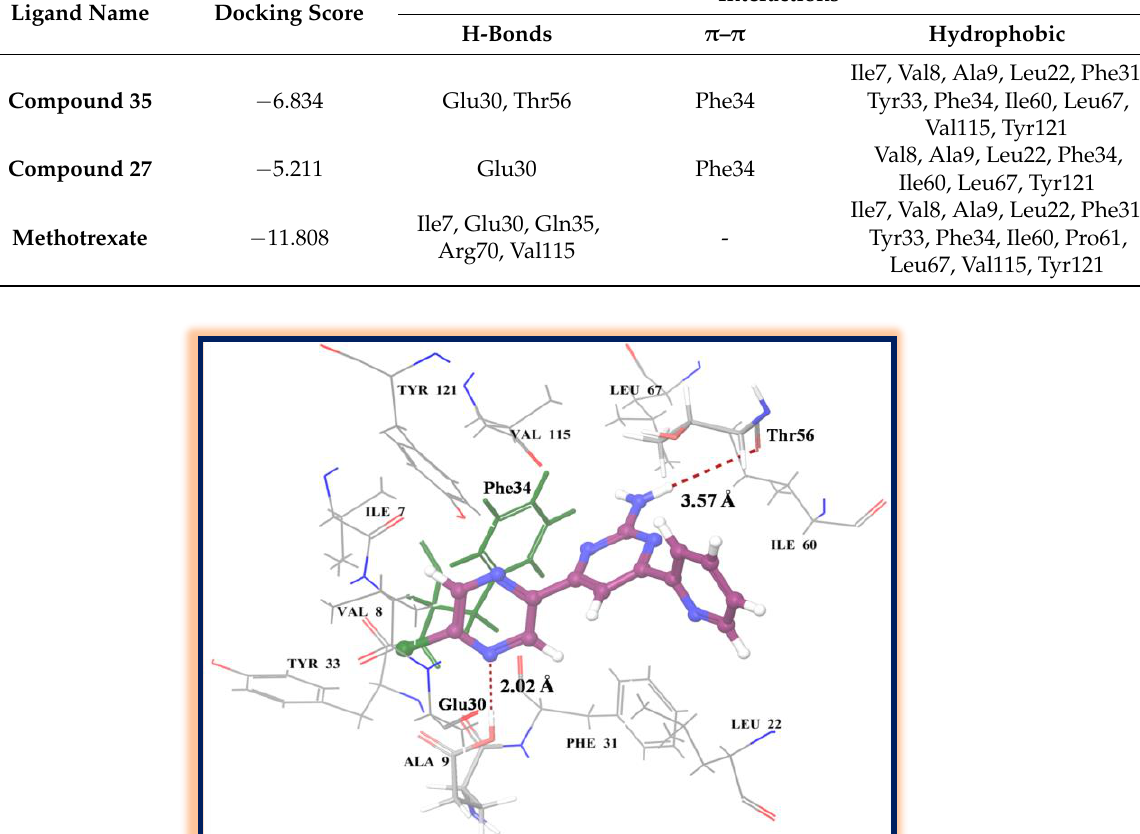
Table 3. GLIDE docking results for compounds 35, 27 and methotrexate at the active site of human dihydrofolate reductase. S. No.